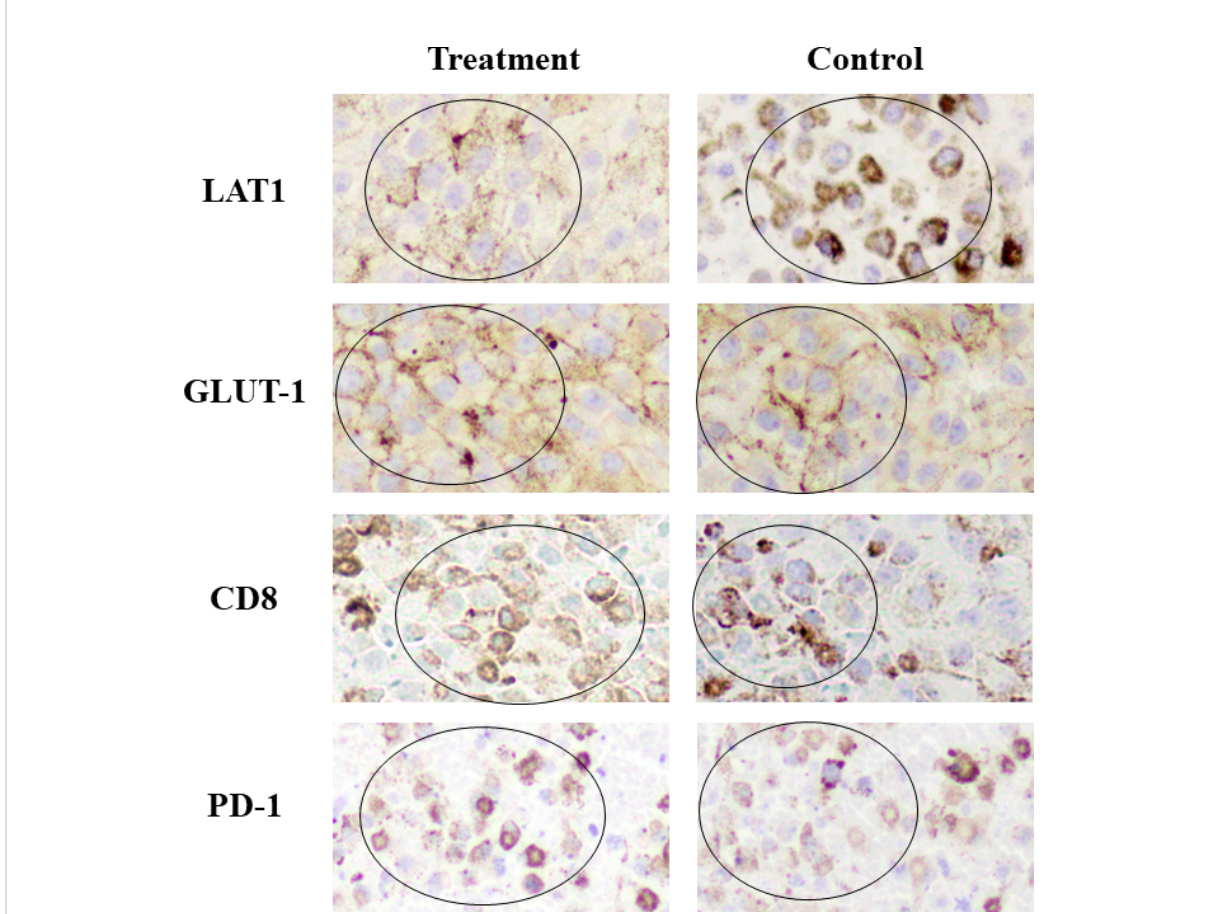
FIGURE 4 Immunohistochemical staining Intense LAT1 and GLUT-1 expression was observed in many areas within the tumor, whereas CD8 and PD-1 expression was in the limited areas within the tumor in both the treatment and control groups. (Positive staining: mainly observed in circled areas) No differences in the expression of LAT1, GLUT-1, CD8, or PD-1 were observed visually between the treatment and control groups. GLUT-1 and CD8 expression in the treatment group appeared slightly higher than that in the control